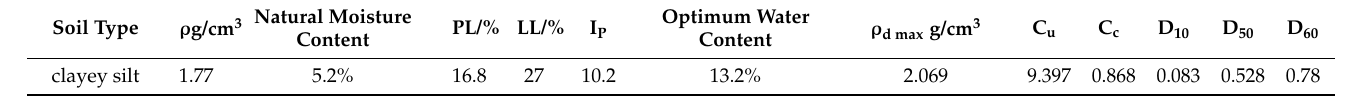
Table 1. Properties of the